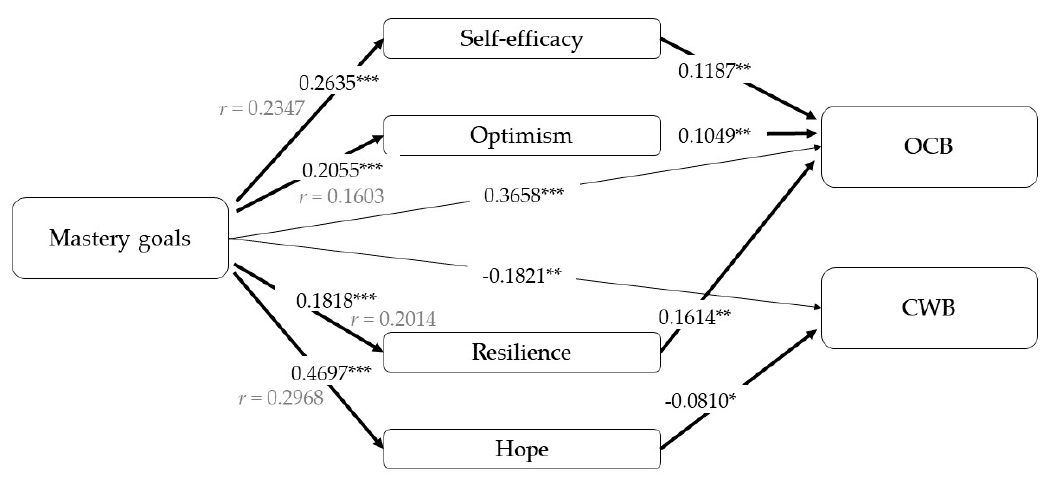
Figure3. Resultsofthemediationmodelswithmasterygoalsasanindependentvariable. Note:[95%CI]; * p < 0.05; ** p < 0.01; *** p < Figure 3. Results of the mediation models with mastery goals as an independent variable. Note: [95% CI]; * p < 0.05; ** p < 0.01; *** p < 0.001.